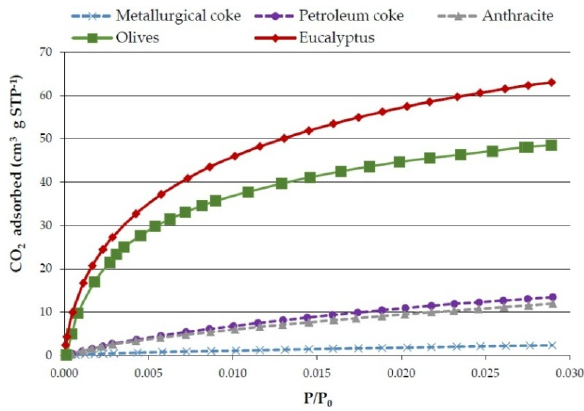
Figure 5. CO 2 adsorption isotherms of commercial reducers and olives and eucalyptus bioreducers (obtained at 750 °C and 3 °C ∙ min − 1 ).